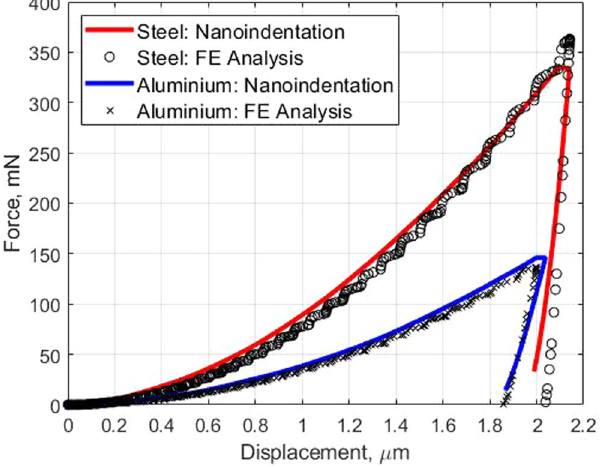
Figure 1. FE analysis and indentation experimental force - displacement for two reference materials.